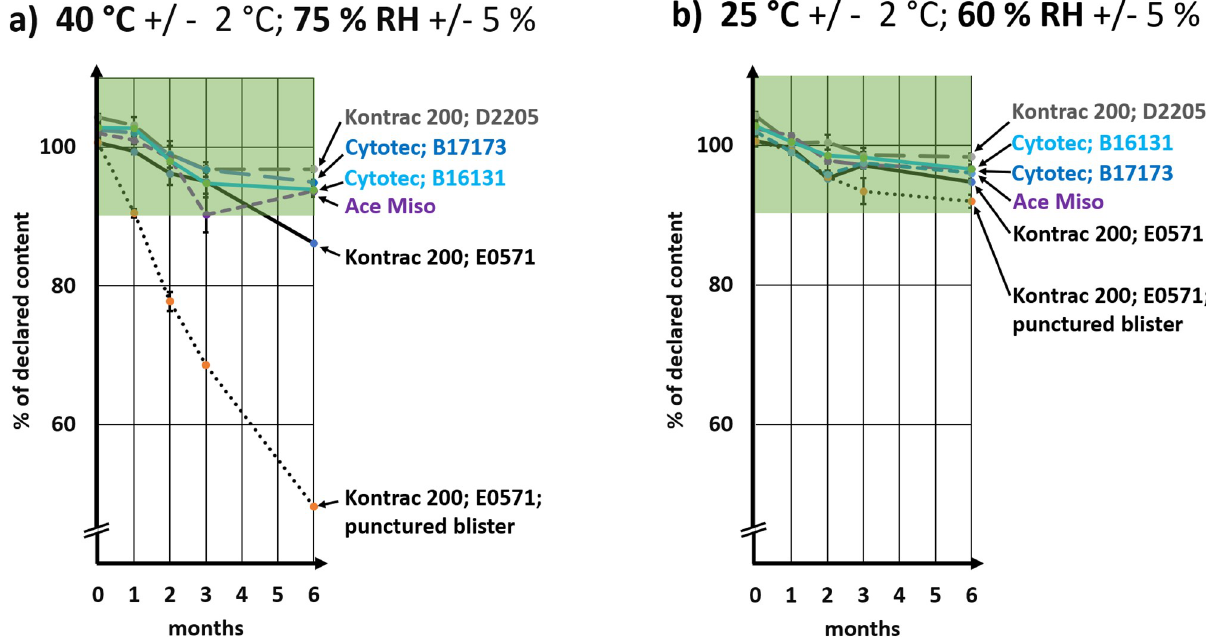
Fig 2. Change of misoprostol content in tablets store for 6 months a) at 40˚C and 75% relative humidity (RH) and b) at 25˚C and 60% RH. Error bars show standard deviation. The International Pharmacopeia requires a content of misoprostol between 90–110% of the declared amount. This range is marked in the